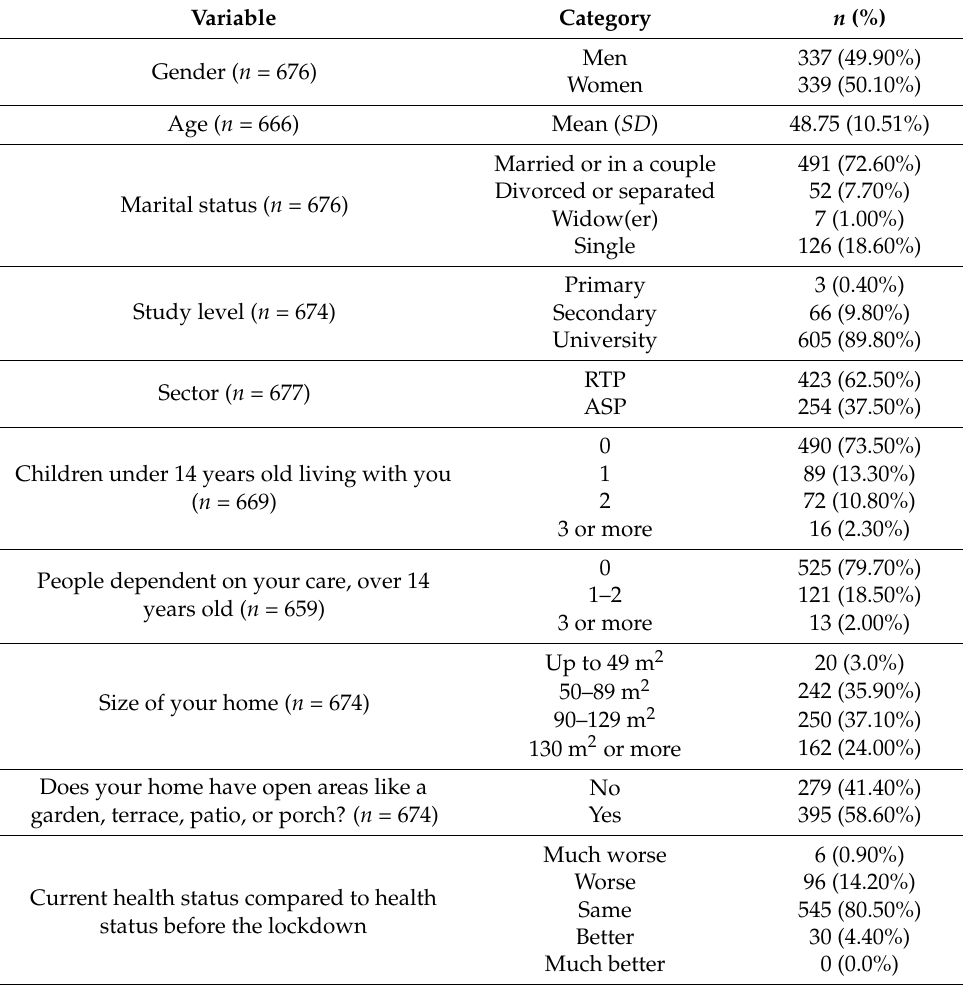
Table 1. Characteristics of the